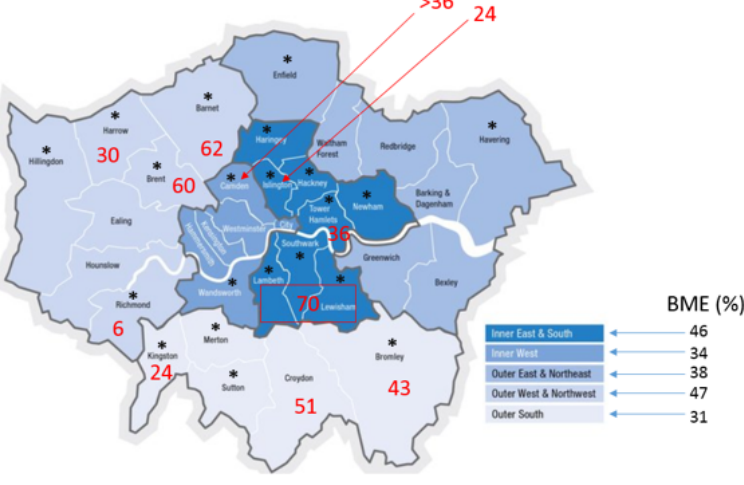
Figure 2. Map of London showing the number of GP practices utilizing the EMIS system (red), boroughs utilizing EMIS (asterisk), and proportion of Black and Minority Ethnic (BME) by region